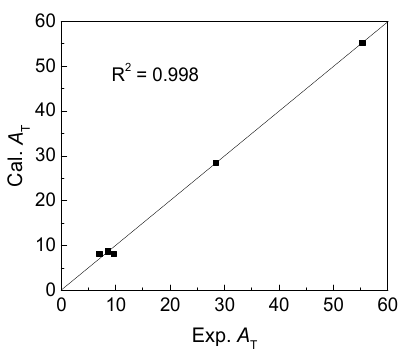
Figure 3. The plots of calculated thermal stabilities (Cal. A T ) versus experimental results (Exp. A T ) for complexes 11 – 15 .